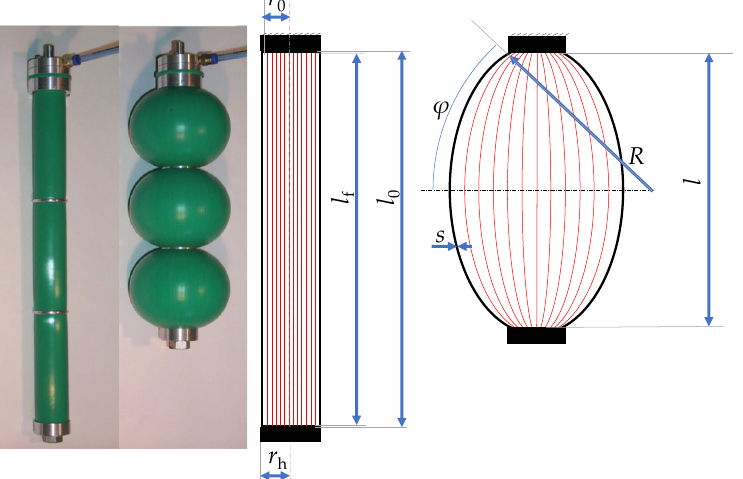
Figure 4. Straight fiber artificial muscle at resting and working condition [42]. r h , r 0 , l 0 , l f , and s are, respectively, the head radius, the initial radius, the nominal length, the fibers length, and the thickness of the inflatable chamber in resting condition; while l , R and ϕ are the length, the radius of curvature, and the central angle of the deformed inflatable chamber, respectively.